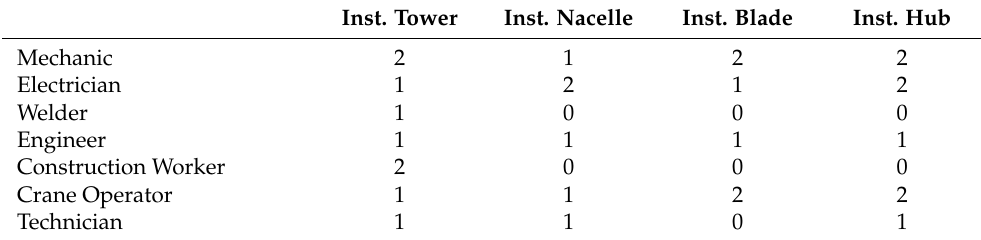
Table 5. Required skills per operation in the extended scenario. Inst. Tower Inst. Nacelle Inst. Blade Inst.